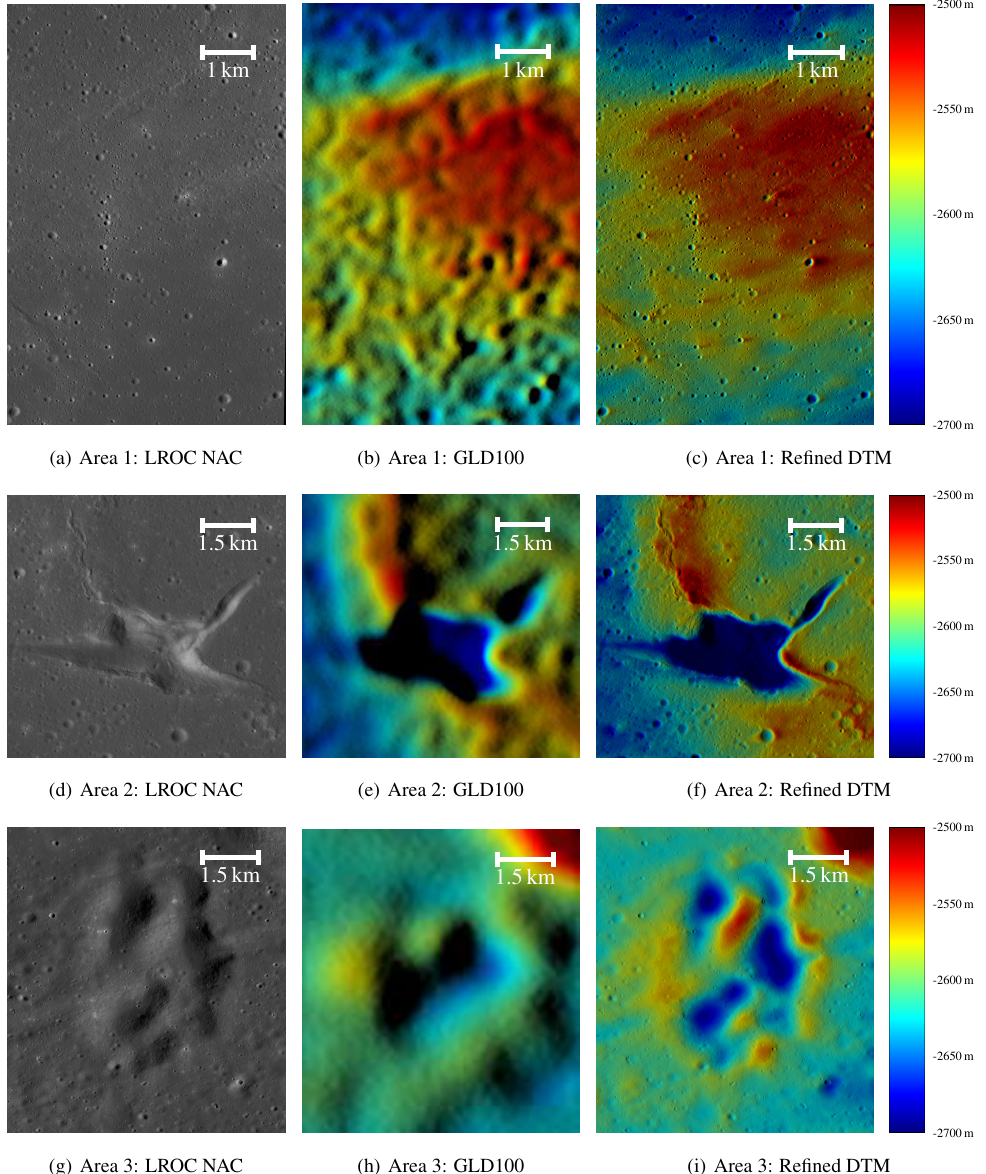
Figure 2: Refined DTMs of the lava flow structures. (a)–(c) LROC NAC image, GLD100 DTM, and the refined DTM of Area 1, respectively. The DTMs clearly show a lava flow of about 100m height which is not visible in the image. (d)–(f) LROC NAC image, GLD100 DTM, and the refined DTM of Area 2, respectively. There is a wrinkle ridge in the north-western part of the image and an irregularly shaped depression which is a possible volcanic vent. (g)–(i) LROC NAC image, GLD100 DTM, and the refined DTM of Area 3, respectively. The smooth depression are assumed to be another possibly volcanic vent. In all cases, the refined DTM captures the image details while the GLD100 constrains the solution and successfully reduces systematic errors originating from the integration of a noisy shading information. The visualization of the DTM was computed by color-coding the depth information and weighting the intensity channel of the image by a Lambertian shading of the DTMs,